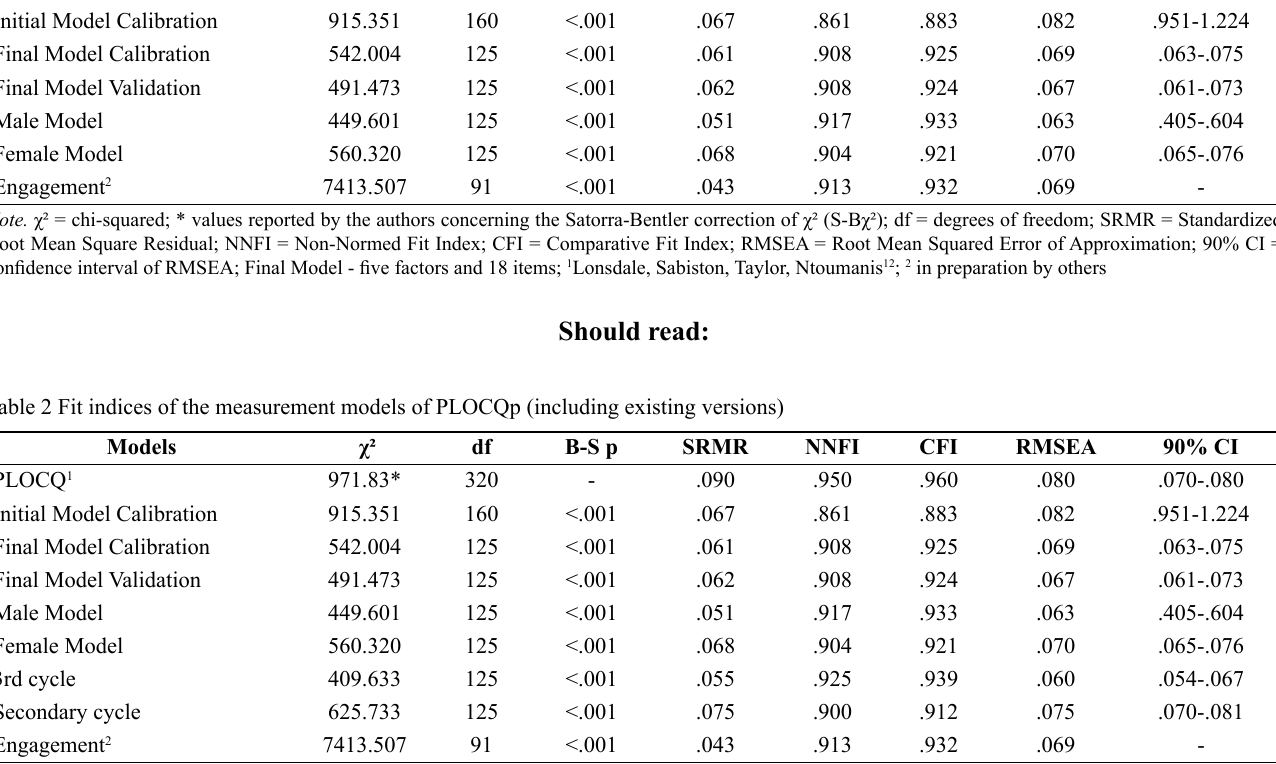
Table 2 Fit indices of the measurement models of PLOCQp (including existing versions) Models Initial Model Calibration